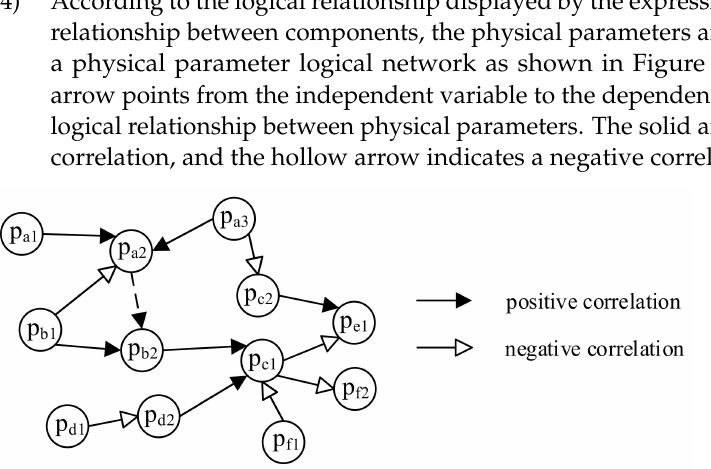
Figure 9. Physical parameter logic network.